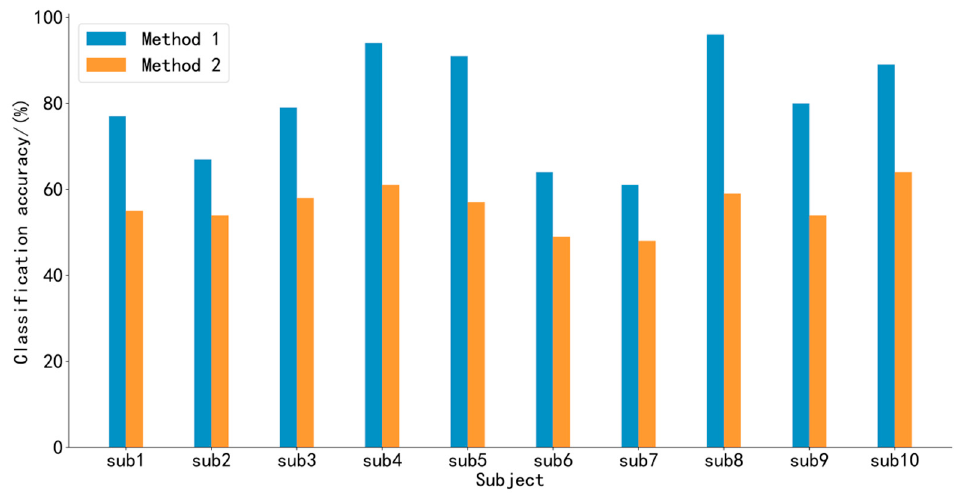
Figure 6. Classification accuracy comparison of Method 1 and Method 2.